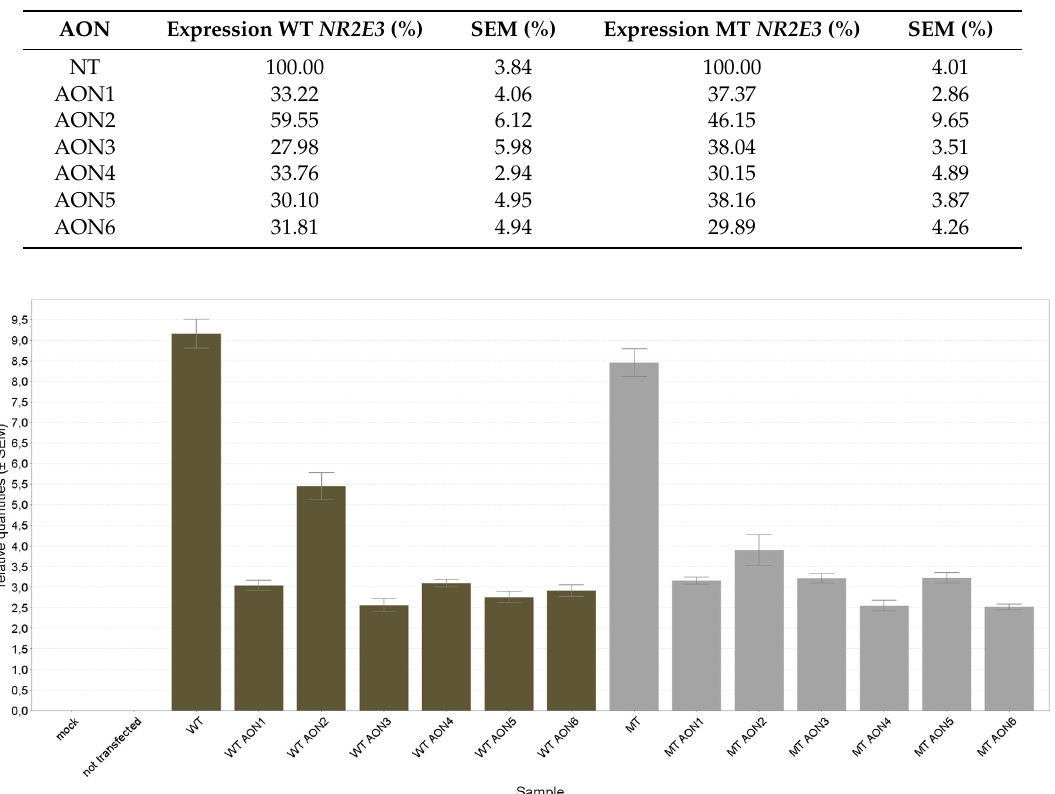
Table 2. Relative expression values of messenger RNA (mRNA) from wild type (WT) or mutant (MT) NR2E3 overexpressed in RPE-1 cells and subsequently treated with AON1–6. Residual expression after AON treatment was calculated relative to the non-treated (NT) sample (=100%). SEM = standard error of relative expression values.